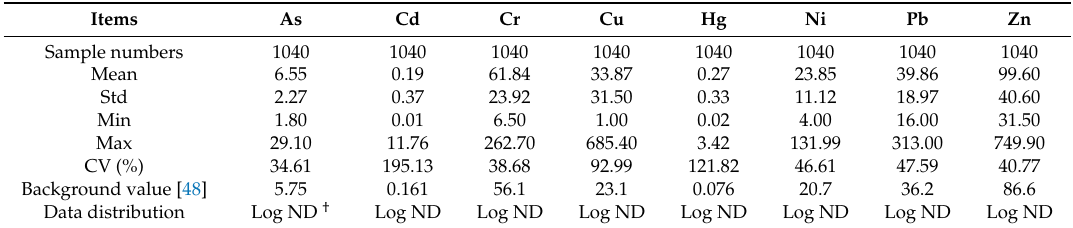
Table 1. Descriptive statistics of heavy metal concentrations in the research area